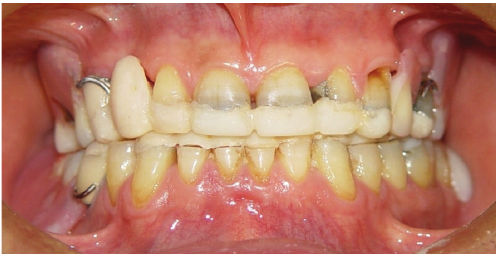
Figure 2: Removable provisional prostheses in place.